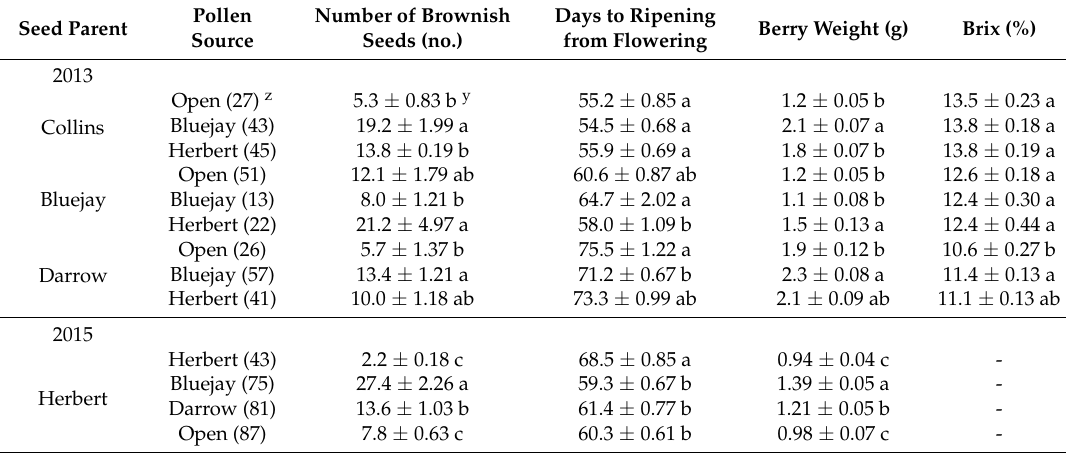
z Numbers in parentheses indicate the number of berries used for analysis. y Different letters within the column and seed parent indicate significant difference at p = 0.05 by the Tukey–Kramer